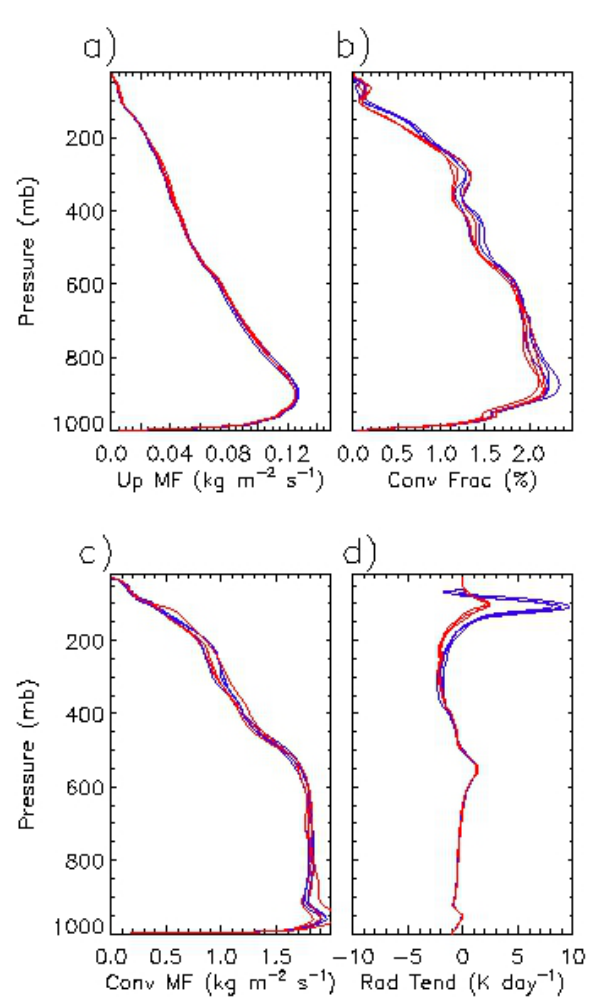
Fig. 8. As in Fig. 6, except for vertical profiles of (a) updraft mass flux, (b) fraction of the domain containing convective updrafts, (c) convective updraft mass flux averaged over cells containing convec- tive updrafts, and (d) temperature tendency due to radiative